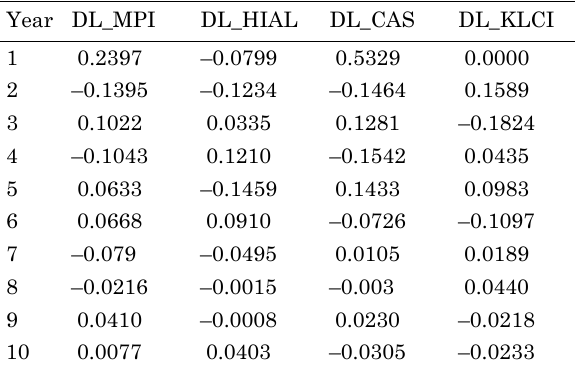
Table 6. Variance decomposition of housing price